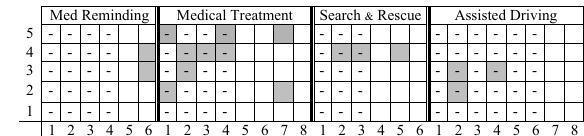
Figure 6 Ethical Turing Test results showing dilemma instances where ethicist’s responses agreed (white) and disagreed (gray) with system responses. Each row represents responses of one ethicist, each column a dilemma (columns arranged by domain). Training examples are marked by dashes.